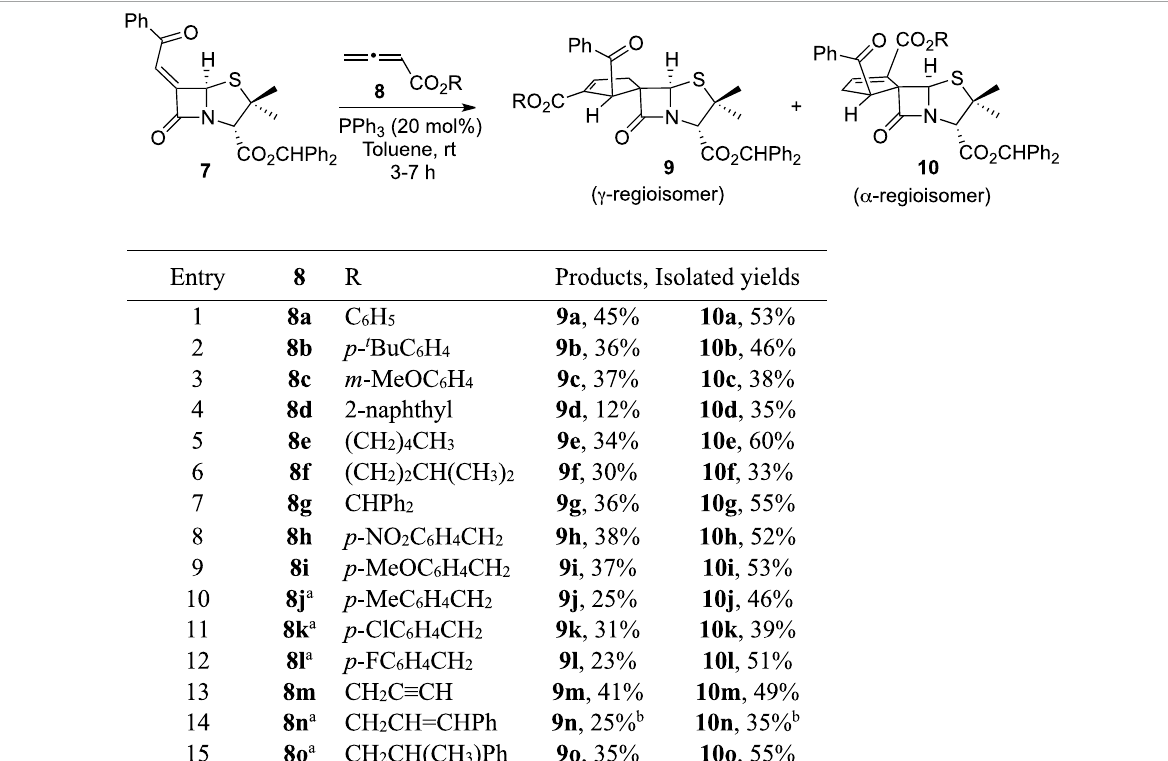
TABLE 1 Structural modulation strategy focused on the exclusive modulation of the position 2 9 of the lead molecule cyclopentene